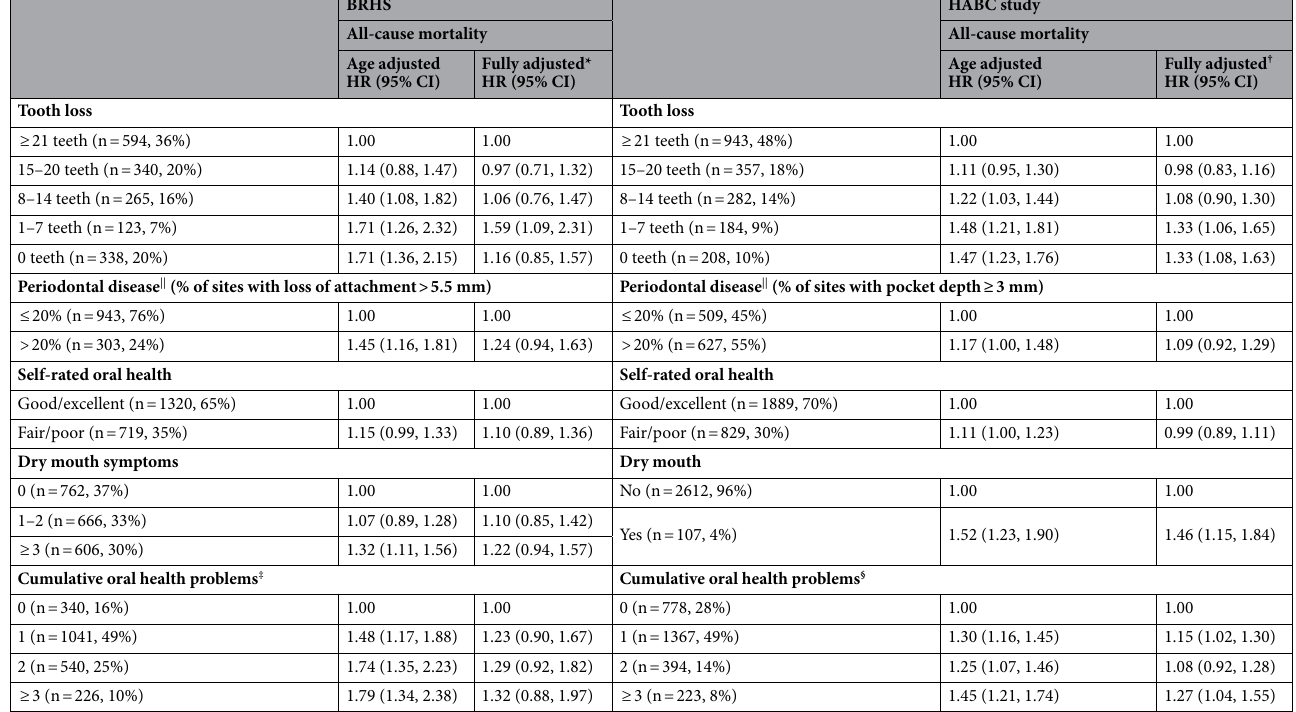
Table 2. Hazard ratios (HR) and 95% confidence intervals (CI) for the association between oral health problems and risk of all-cause mortality in older people in the BRHS after 9 years of follow-up and in the HABC Study after 15 years of follow-up. *Age, social class, smoking, alcohol, physical activity, history of CVD and diabetes, BMI, EDI score, hypertension, triglycerides, HDL, CRP, IL-6, fibrin d-dimer, hsTnT. † Age, gender, race, education, smoking, alcohol, physical activity, history of CVD and diabetes, BMI, HEI score, hypertension, total blood cholesterol, CRP, IL-6. ‡ Includes < 21 teeth, difficulty eating, symptoms of dry mouth, and sensitivity to hot/cold/sweet. § Includes < 21 teeth, difficulty eating, dry mouth when eating, and limit of food due to gum problems. || Only measures of periodontal disease with positive associations